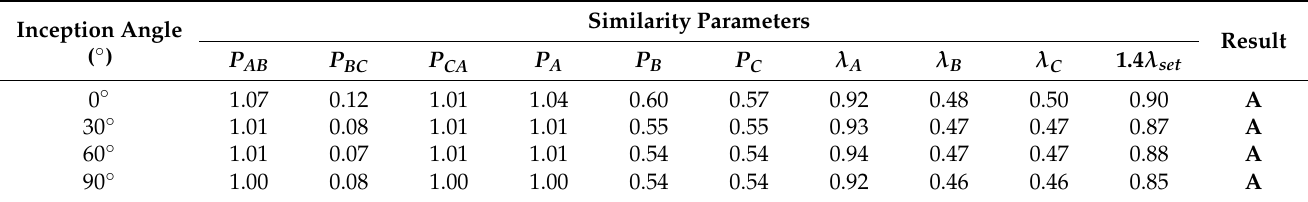
Table 7. Similarity parameters and faulty phase selection results under the influence of the fault inception angle. Inception Angle ( ◦ )